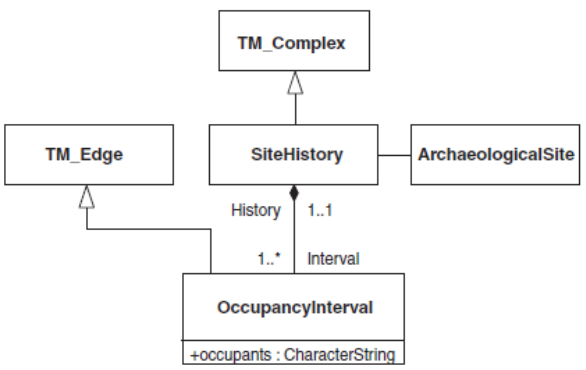
Figure 6 The history of an archaeological site by the use of TM_TopologicalComplex (ISO,